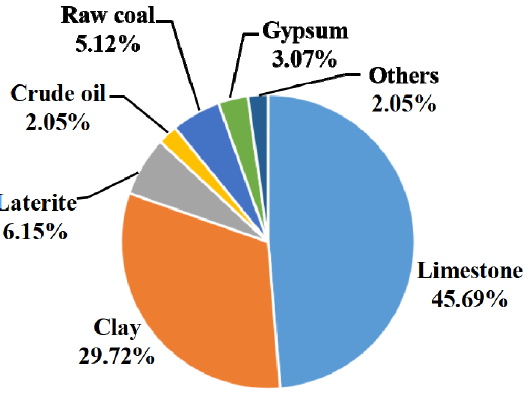
Figure 5. Environmental impacts to ADP of each substance in blended cement with Chinese data.